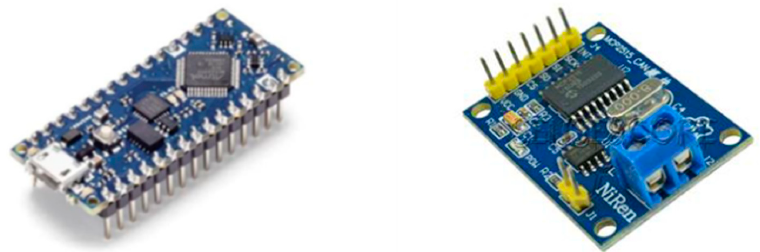
Figure 8. Arduino Nano (on the left) and MCP2551 Can Bus Module (on the right).